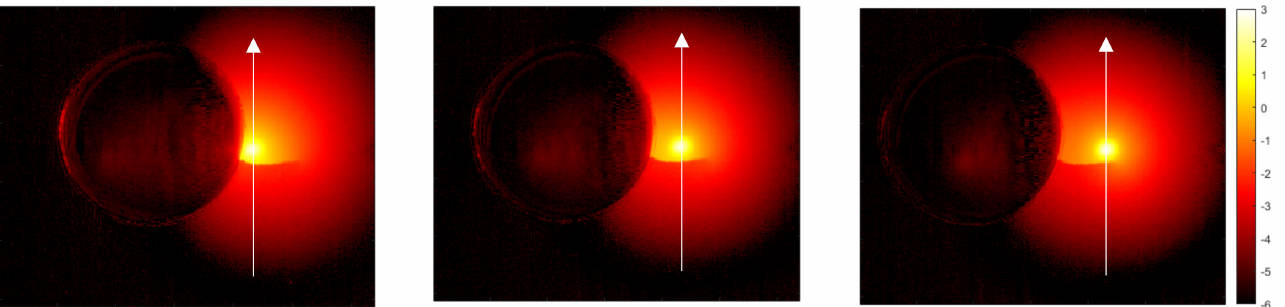
Figure 7. Natural logarithm amplitude thermogram at three different positions of the laser spot at f = 11 Hz. The temperature discontinuity produced by the crack is clearly noticeable. The white arrows indicate the profiles that will be analyzed for sizing the crack.